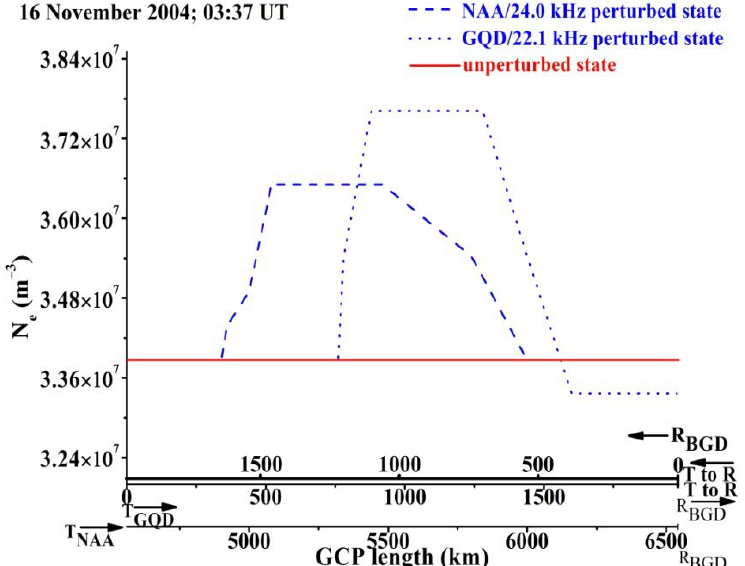
Figure 9. Electron density changing along GCP path towards the Belgrade receiver, for considered VLF signal waveguides (NAA/24.0 kHz in dashed line and GQD/22.1 kHz in dotted line), for unperturbed (red) and perturbed (blue) ionospheric states, on 16 November 2004 (R is for receiver, T is for transmitter, black arrows on x axis point the direction of view).